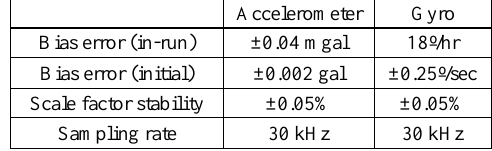
Table 1. Specification for the MEMS IMU system